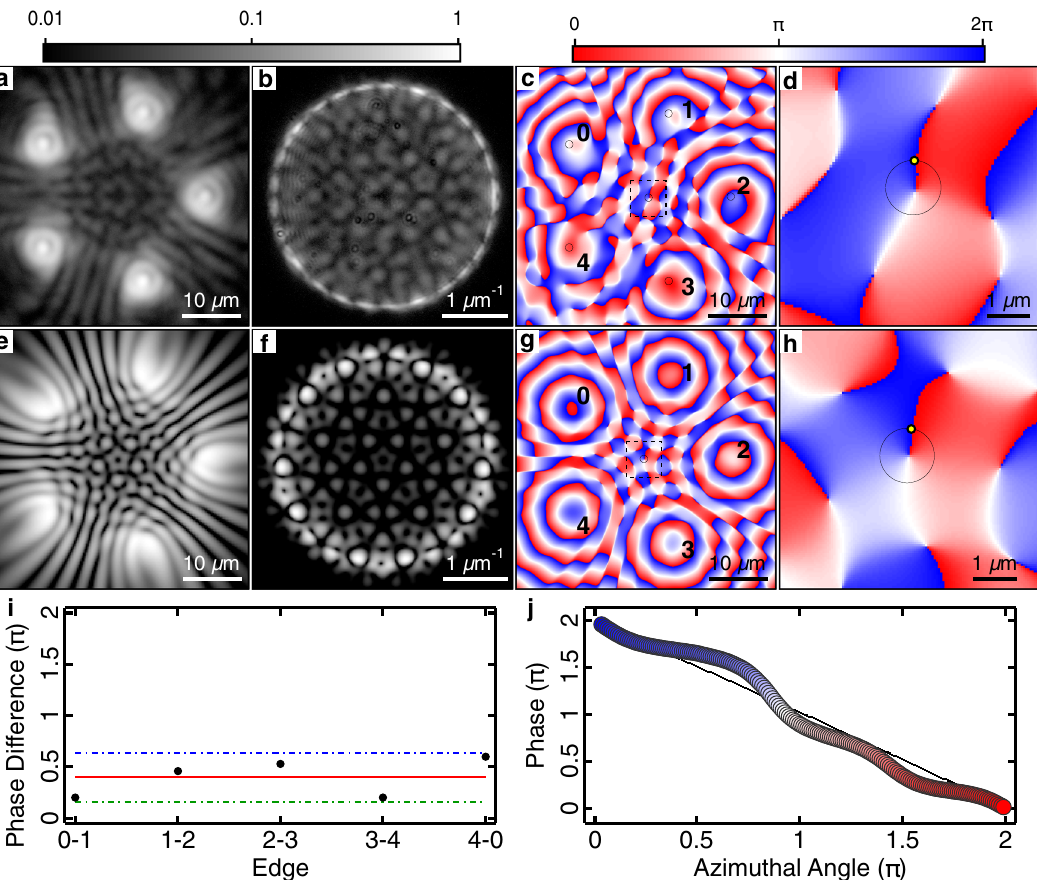
Fig. 3 Single shot of a pentagon of polariton condensates with a singly charged vortex at the centre. Pentagon condensate with a charge m = − 1 vortex. a Experimental real-space PL, b Fourier-space PL and c , d phase extracted from interferometry from a single instance of the condensate. Simulated steady state m = − 1 vortex wavefunction e real-space density, f Fourier-space density, and g , h phase. d , h Zoomed-in regions of the dashed squares in c , g , respectively. i Phase difference between adjacent condensates (black dots) around the polygon extracted from the black circles in c . The red line is the expected phase difference of θ i , i + 1 = 2 π /5. Green and blue dash-dotted lines mark the maximum deviation. j Line pro fi le extracted along the black circle in d , h demonstrating a full 2 π phase winding. Yellow dots correspond to azimuthal angle equal to zero. Experimental data are represented by the coloured disks and numerical simulation by the black-dotted